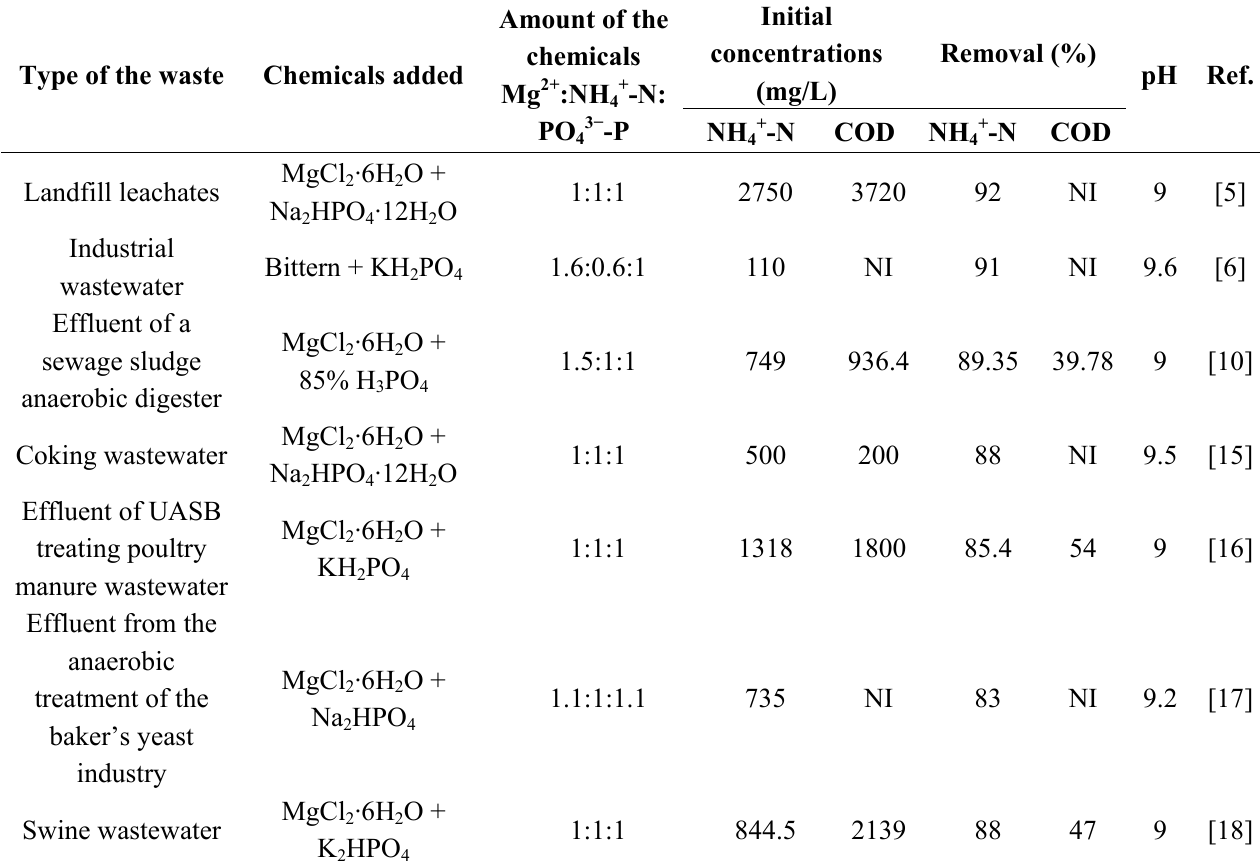
Table 1. Removal of NH 4+ -N and PO 43 − -P by struvite precipitation from different